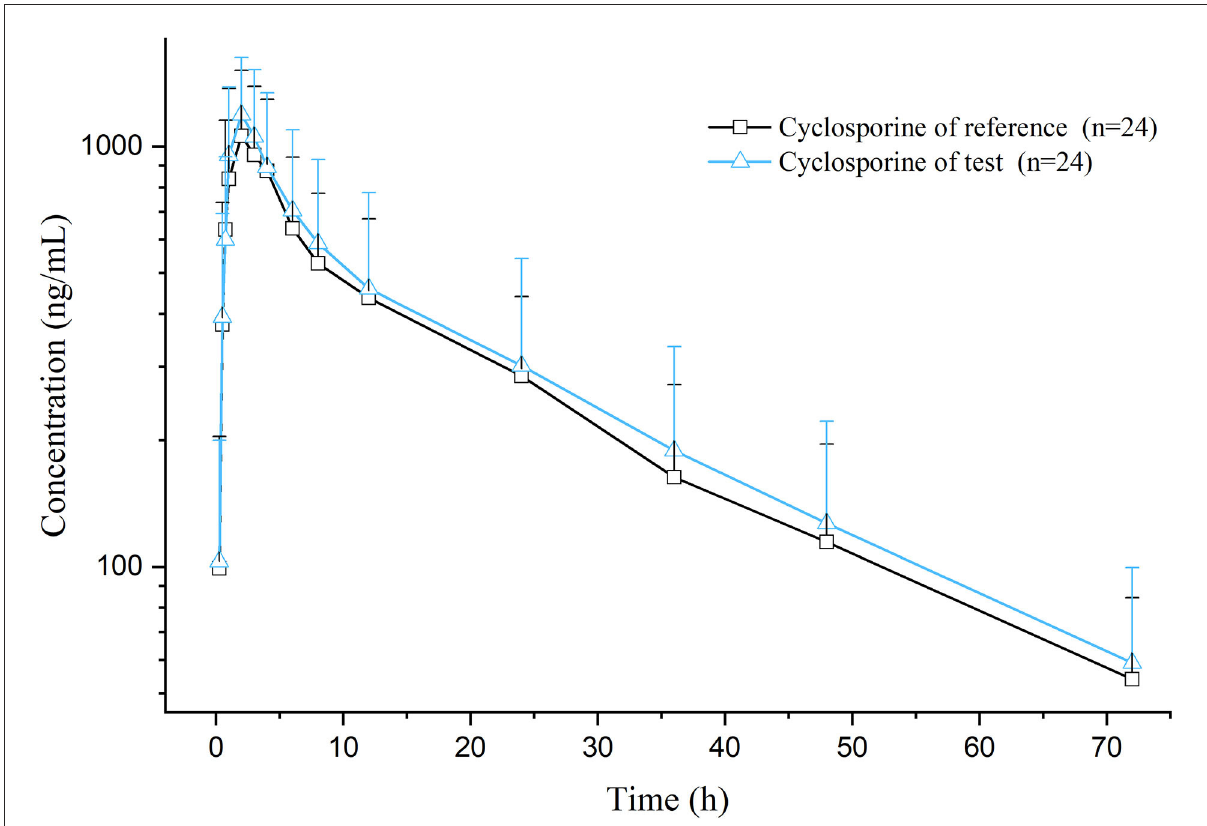
FIGURE1 Semilogarithmic plot of the cyclosporine plasma concentrations–time